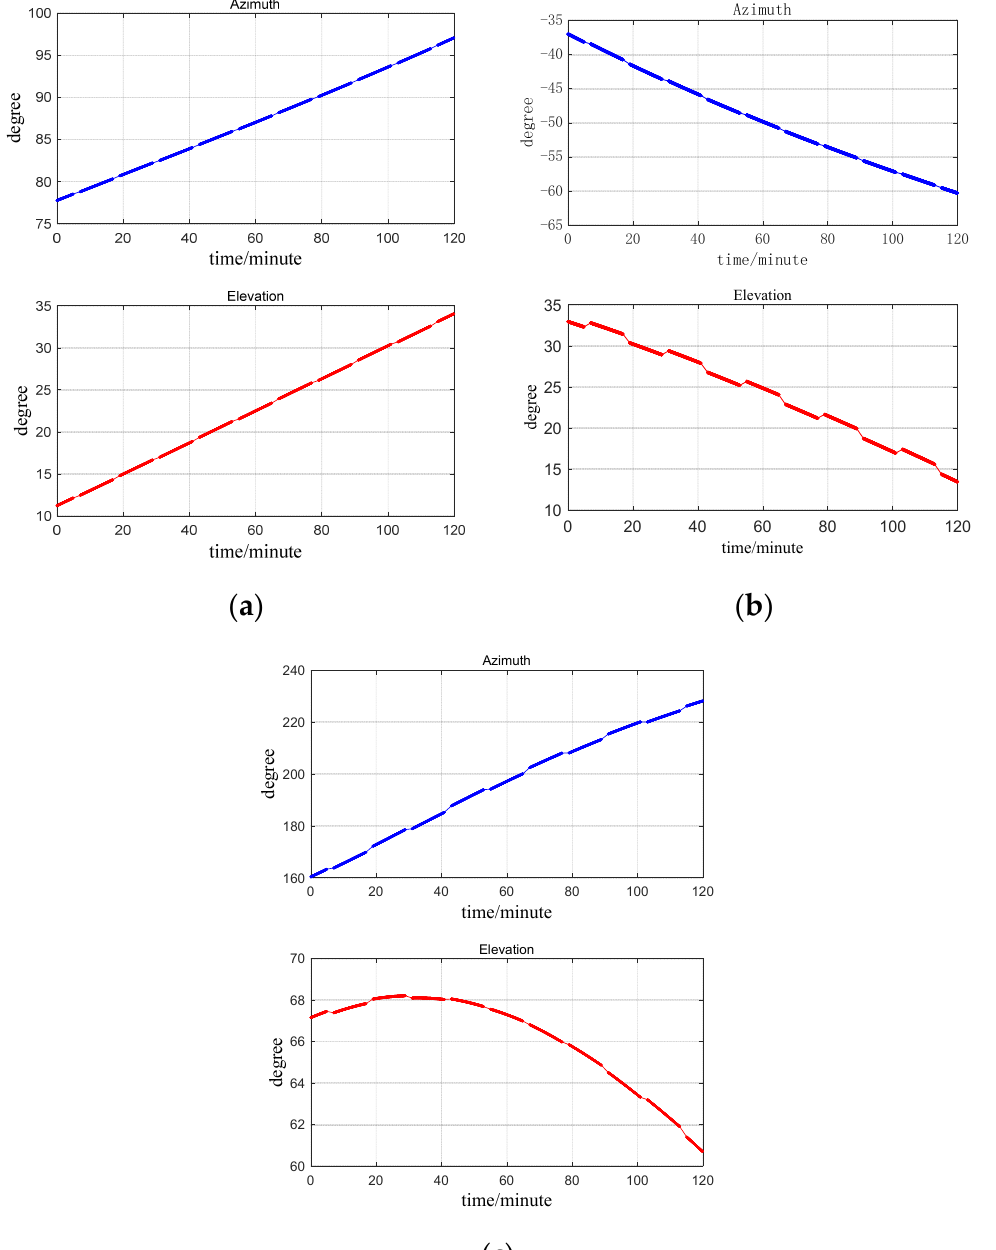
Figure 12. Analysis of antenna pointing angle during the observation: ( a ) elevation angle of CEB varies from 12 to 33 degree; ( b ) elevation angle of NNO varies from 33 to 13 degree; ( c ) elevation angle of KSH varies from 61 to 68 degree.